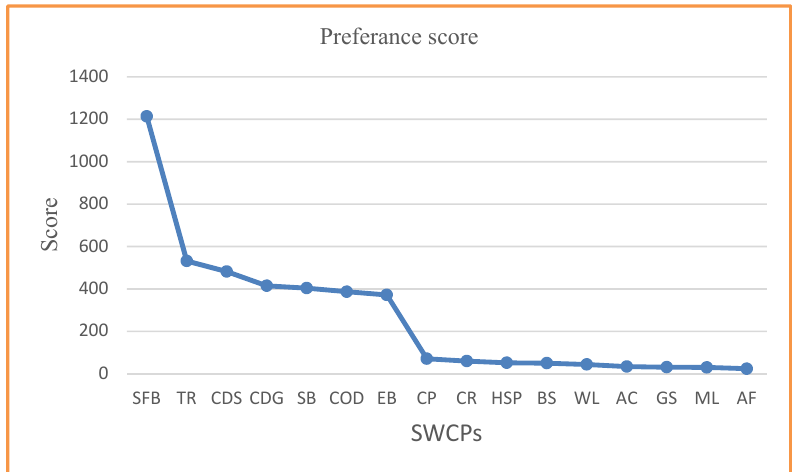
Figure 8. Farmers’ preference to different SWCPs.